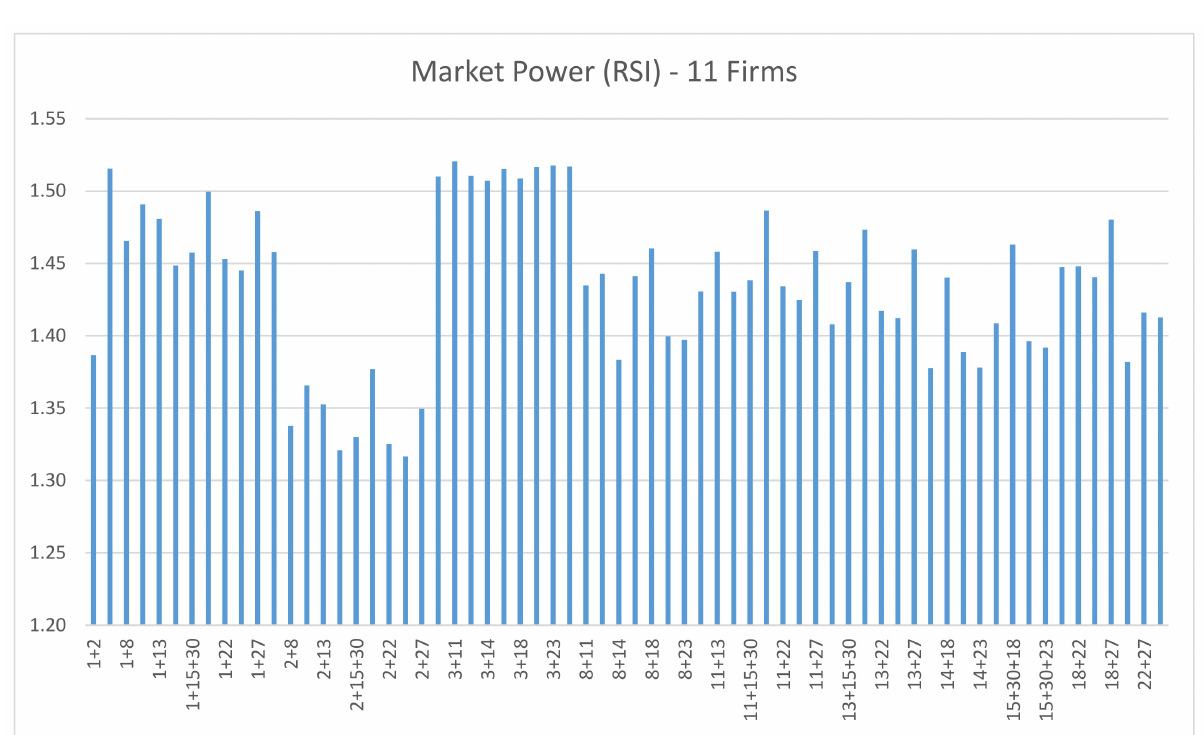
Figure 6. RSI for 11 firms’ setting